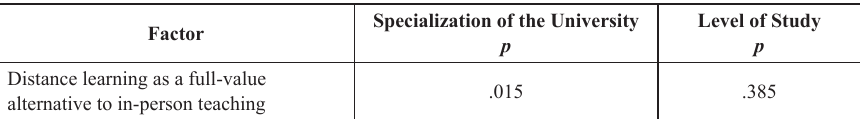
Table 7. Significance of differences between students’ attitudes according to